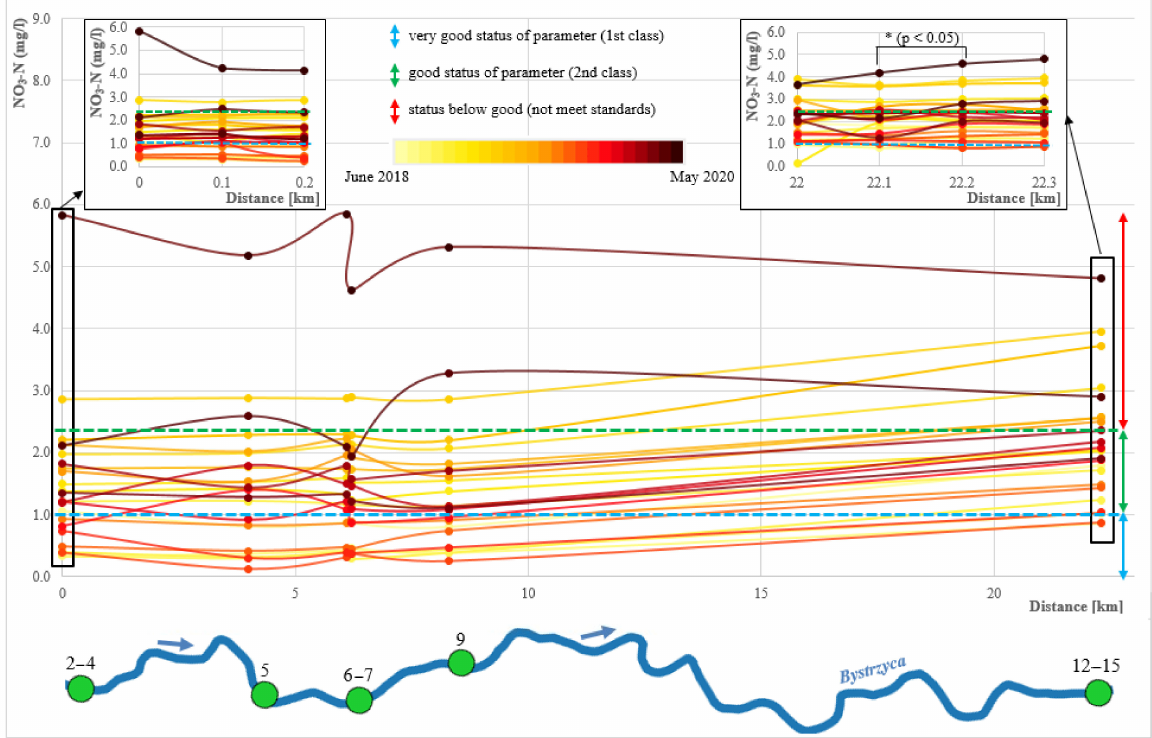
Figure A2. Temporal and spatial variability of NO 3 -N at the tested measurement points, including the physicochemical condition of the parameter and statistical significance within the Sadowice, Skałka, and Marszowice HPs ( p <